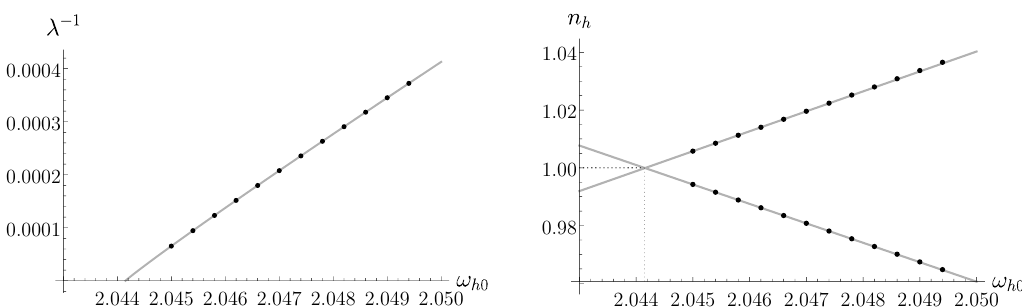
Figure 18. As seen in figure 17, log g tt ( z ) is periodic in log z . The left plot demonstrates the reciprocal wavelength of log g tt (labelled λ − 1 ) as a function of ω h 0 . The data collected (black points) are well fitted to a simple power law model (grey curve), with exponent 0 . 96 ± 0 . 01 . The right plot displays n h , see equation (4.2), as a function of ω h 0 for the first two plateaus. The data for either of the plateaus are well fitted to a linear